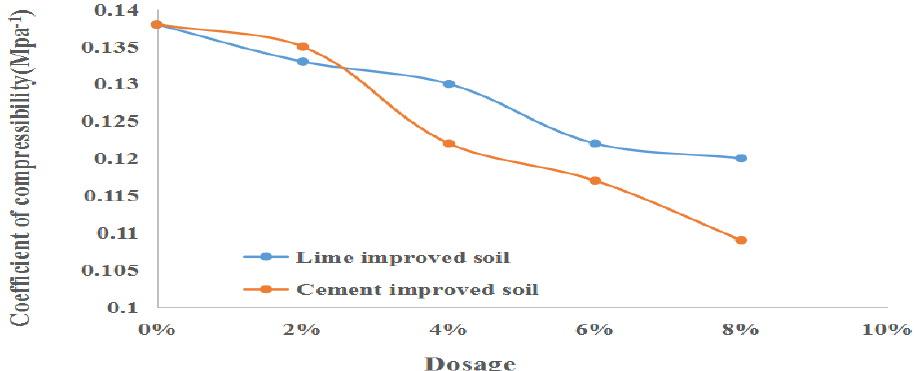
Figure 3. Variation curve of compression coefficient of improved soil with content.